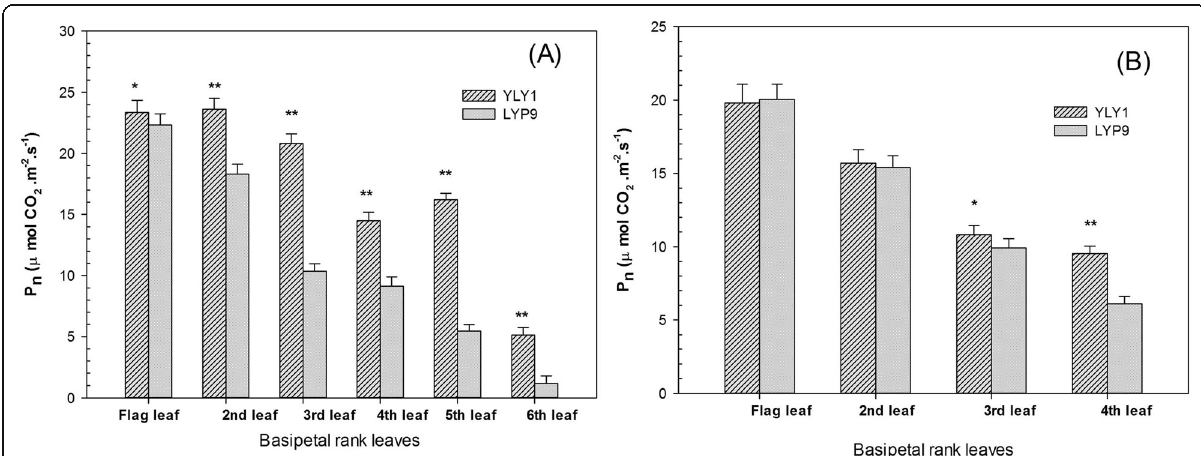
Fig. 1 Net photosynthesis rates of different leaves for cv. YLY1 and LYP9 at the milk ( a ) and dough ( b ) stages in 2011. The bar is the standard deviation of 5 replicates. “ * ” , “ ** ” means significance level at p = 0.05 or p = 0.01,